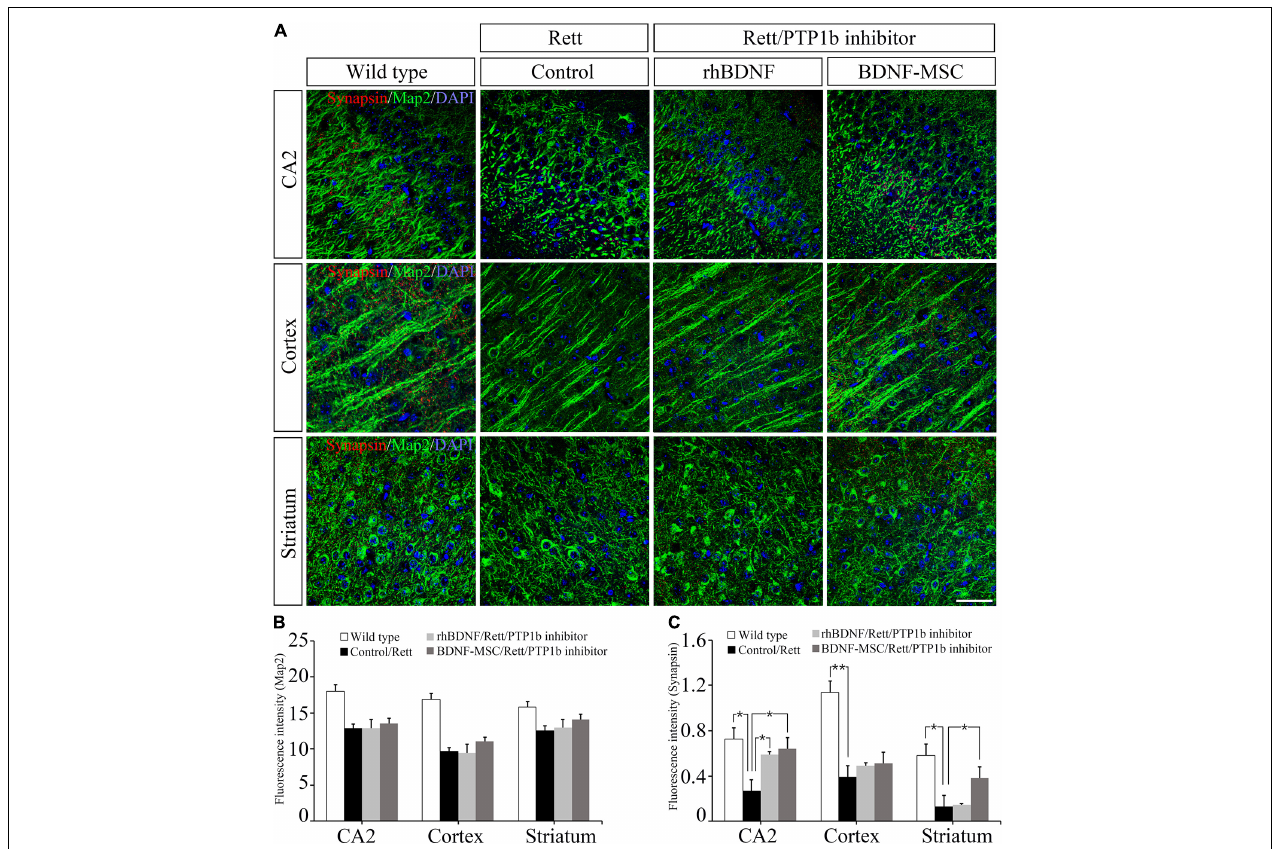
FIGURE 6 | Immunostaining analysis for detection of synapses. (A) Immunostaining confocal image showing expression of Map2 (green), synapses (red), and DAPI (blue) in mouse brain tissue. The expression intensity of (B) Map2 and (C) synapses were measured using ImageJ software. Scale bar = 50 µ m * p < 0.05, ** p < 0.01.